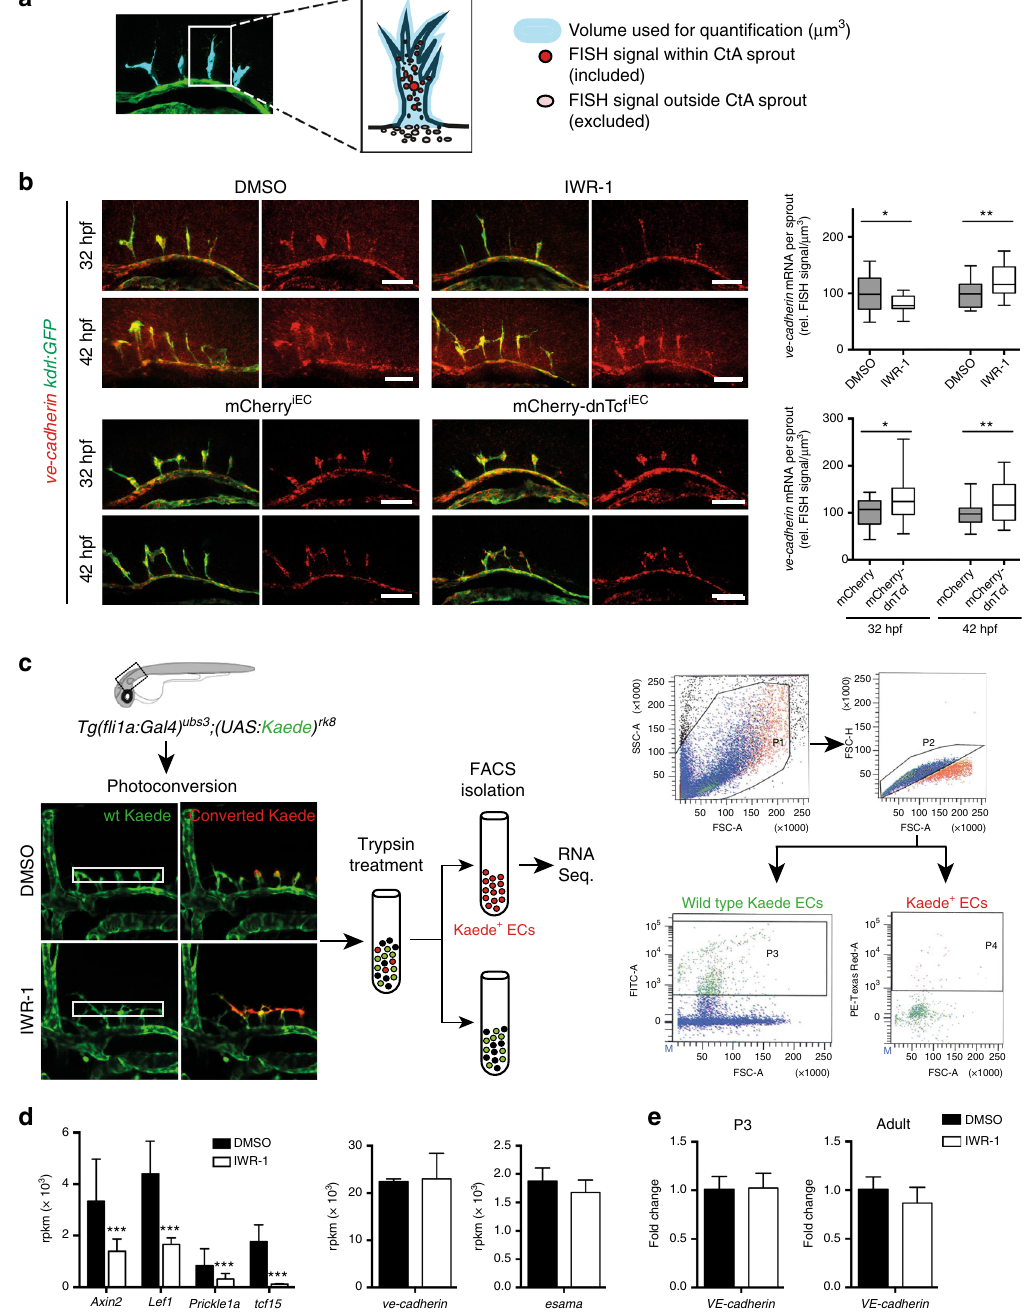
Fig. 4 Wnt signaling does not regulate ve-cadherin mRNA expression. a Whole mount fl uorescent in situ hybridization (FISH, red) in combination with anti- GFP immunostaining (green) of Tg(kdrl:GFP) s843 embryos. For quanti fi cation the FISH signal within CtA sprouts was normalized to the respective GFP volume (blue) of each sprout. b Inhibition of Wnt signaling either by incubation with IWR-1 or expression of mCherry-dnTcf iEC did not severely affect ve- cadherin mRNA expression at 32 or 42 hpf. Treatment with IWR-1 resulted in slightly decreased ve-cadherin mRNA levels in CtA sprouts at 32 hpf, but in increased ve-cadherin mRNA levels at 42 hpf (32 hpf: DMSO: n = 16, N = 6, and IWR-1: n = 15, N = 6; 42 hpf: DMSO: n = 28, N = 7, and IWR-1: n = 19, N = 7). After mCherry-dnTcf iEC expression in ECs ve-cadherin mRNA expression was slightly increased (32 hpf: mCherry iEC : n = 20, N = 6; mCherry-dnTcf iEC : n = 18, N = 7; 42 hpf: mCherry iEC : n = 40, N = 7; mCherry-dnTcf iEC : n = 16, N = 7). Quanti fi cations were represented by Box-and-Whisker plots with median (center line), 25th and 75th percentiles (bounds of box) and Min-to-Max (whiskers), * p < 0.05, ** p < 0.01, *** p < 0.001, Student ’ s t -test; n, number of CtA volumes analyzed; N, number of embryos analyzed. Scale bars: 50 µ m. c , d Expression levels of ve-cadherin or esama were not altered by inhibition of Wnt signaling, whereas classical Wnt-target genes (e.g., axin2 , lef1 ) were downregulated. For RNA sequencing, CtA ECs of Tg( fl i1a:Gal4);(UAS:Kaede) embryos, which were treated with IWR-1 or DMSO, were photoconverted using the confocal microscope laser and isolated by FACS (photoconverted Kaede ECs = Kaede + cells = P4) ( n = 3). e Expression levels of VE-cadherin are not affected by IWR-1 treatment. RT-qPCR analysis of Values in d , e represent mean ± SD, * p < 0.05, ** p < 0.01, *** p < 0.001, n, number of biological replicates. BECs, brain ECs, CtAs, central arteries; ECs,